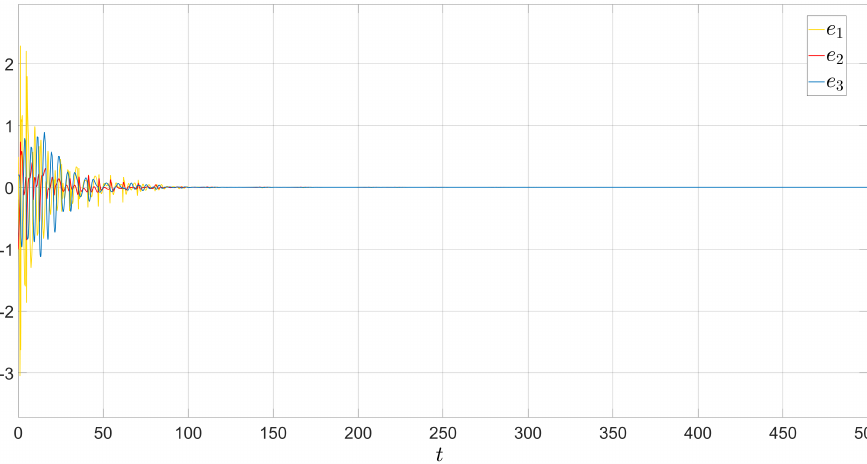
Figure 8. Synchronization